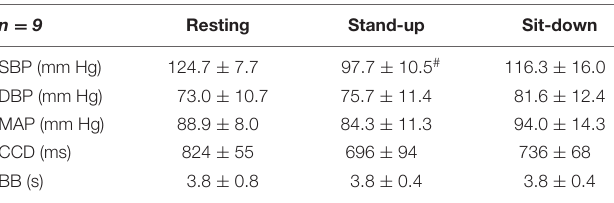
TABLE 1 | Hemodynamic and respiratory parameters of the participating subjects, # indicates significant difference compared with the resting group. n = 9 Resting Stand-up Sit-down